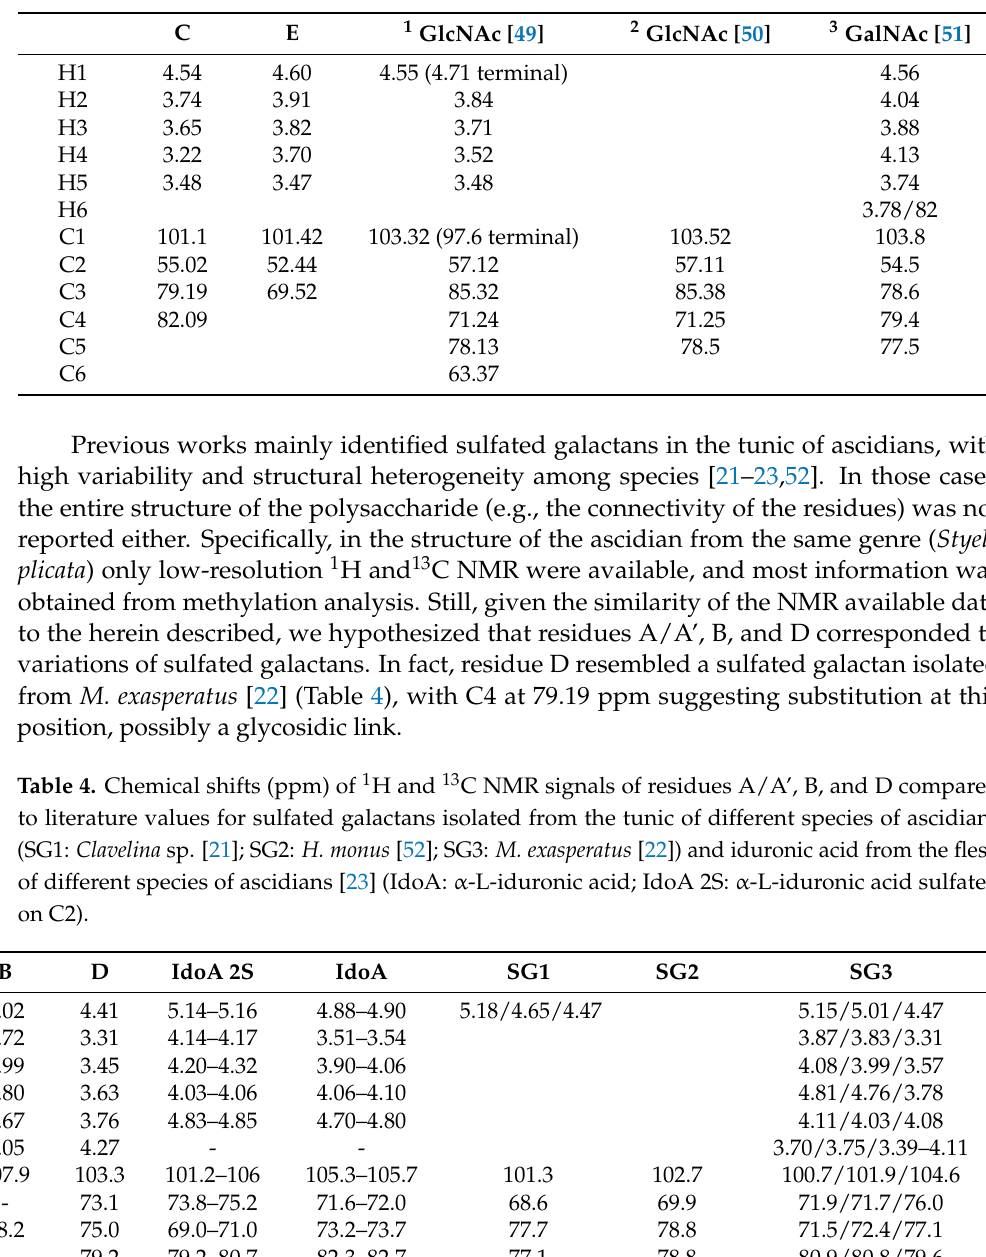
Table 3. Chemical shifts (ppm) of 1 H and 13 C NMR signals of residues C and E compared to literature values. The 1 N-acetyl glucosamine in hyaluronic acid hexasaccharides; 2 N-acetyl glucosamine in